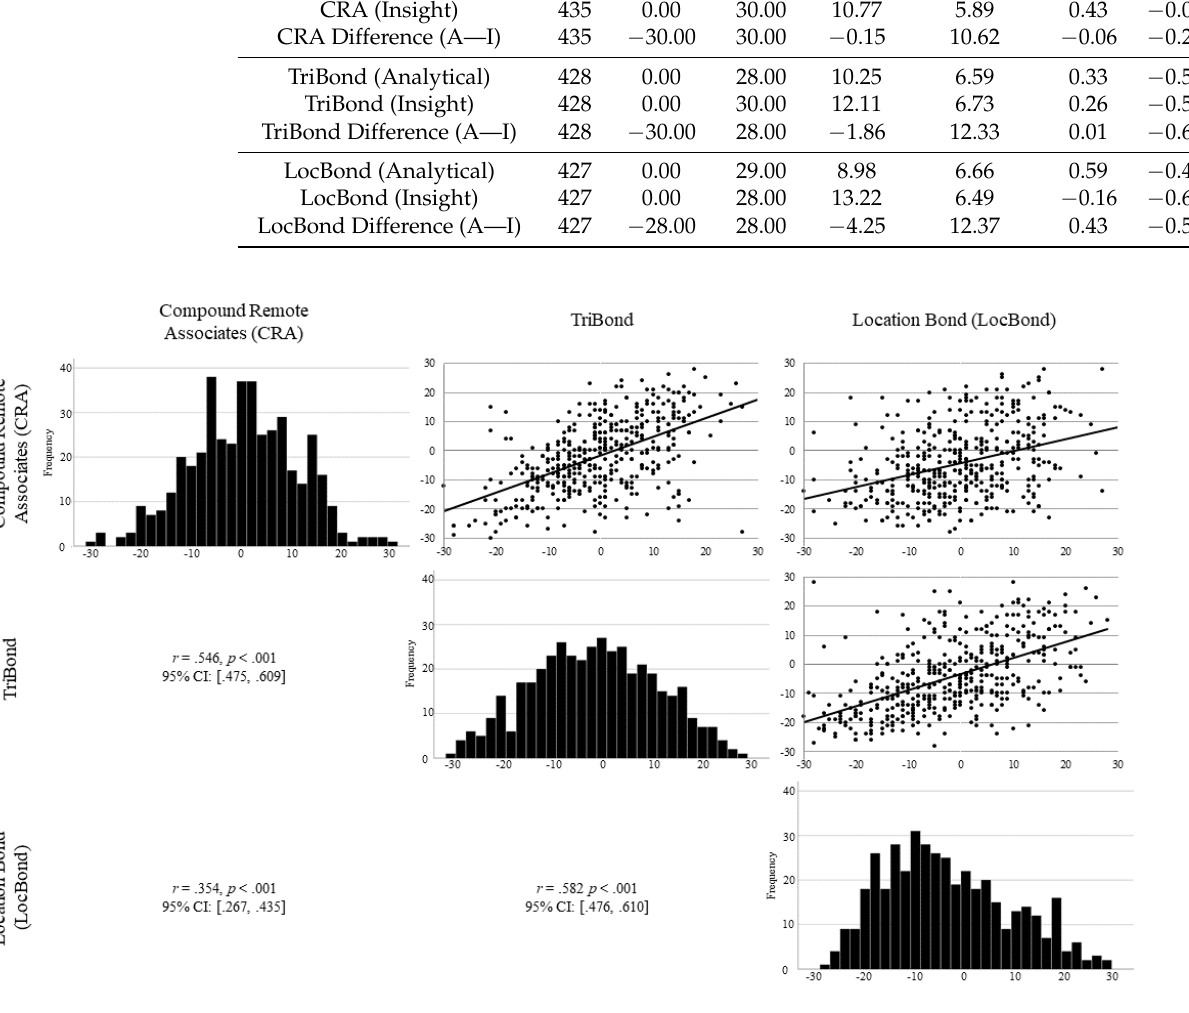
5 The curious reader may be interested in the relations between cognitive abilities (working memory capacity, attention control, episodic and semantic memory, and crystallized and fluid intelligence) and strategy reporting. We fit a model with a strategy usage latent factor and assessed whether those cognitive abilities predicted strategy usage. This exploratory analysis produced a model with overall acceptable fit, χ 2 (187) = 336.703, p < 0.001, CFI = 0.926, RMSEA = 0.042 [0.035–0.049]. However, no cognitive ability was shown to be a unique predictor of strategy reporting. Additionally, the model accounted for only 6.3% of the variance in strategy usage, which indicates that strategy adoption may be fairly independent of cognitive